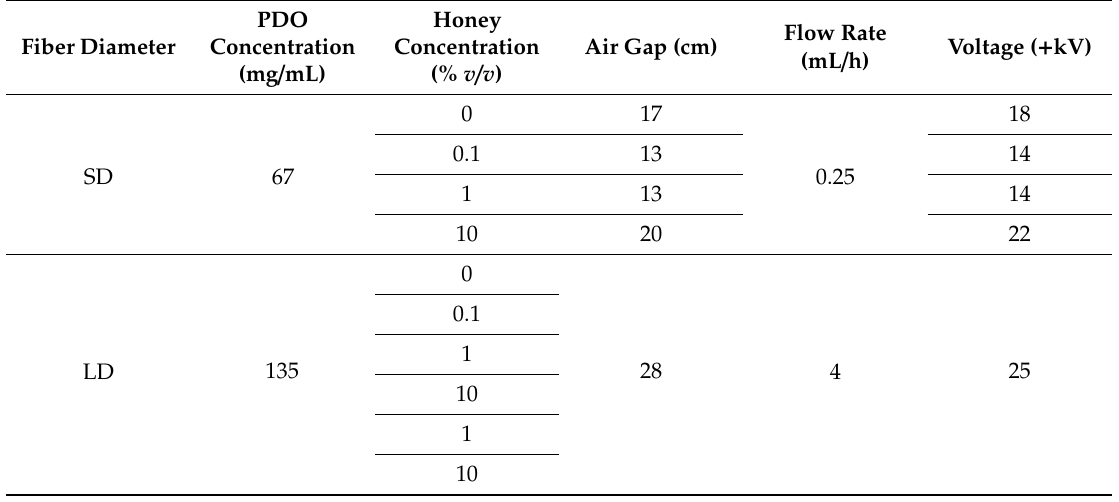
Table 1. Electrospinning parameters for each template type at low humidity conditions. Due to fluctuating humidity in the laboratory throughout this study, two sets of parameters had to be used to maintain consistent fiber diameters for each template